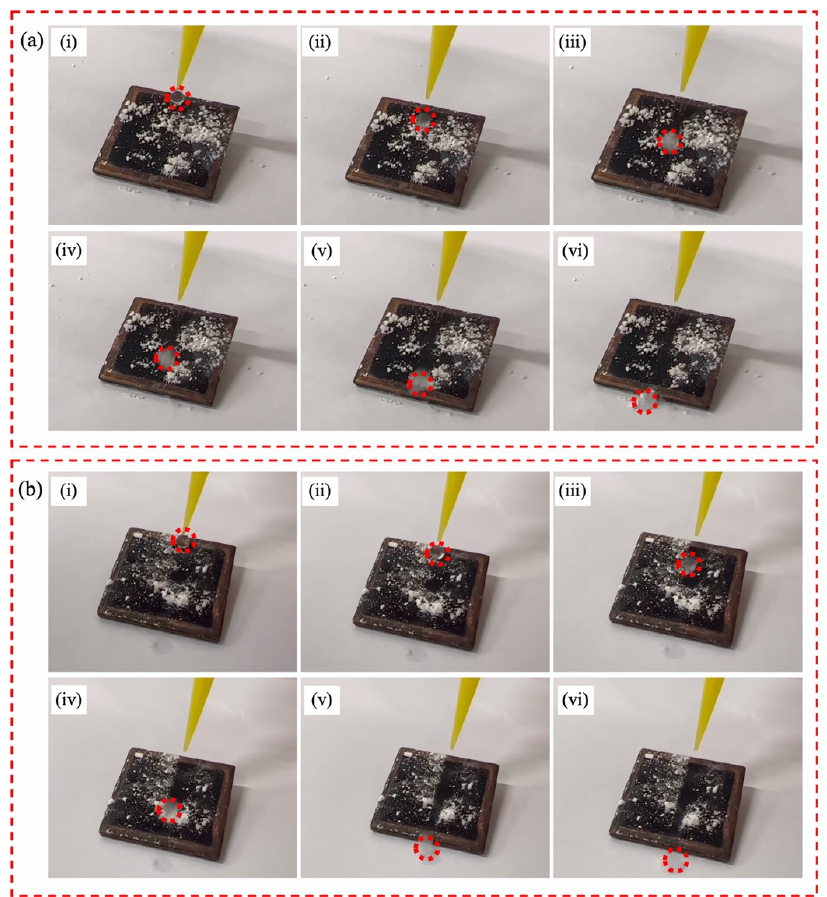
Figure 12. Self-cleaning process of the superhydrophobic surface: ( a ) inclination angle of 8°; ( b ) inclination angle of 20°. Red circle implies the water droplet.